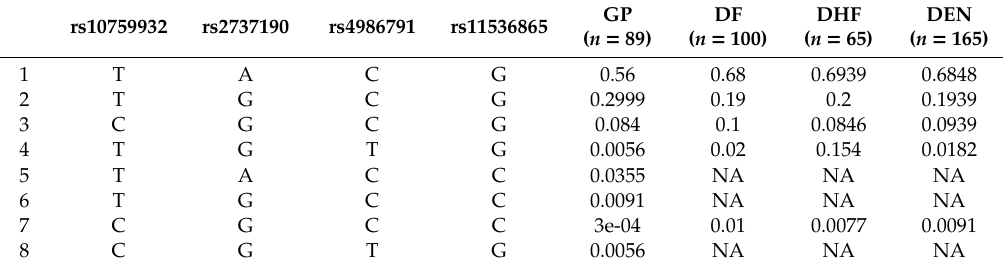
Table 7. Estimation of the haplotype frequencies of the TLR4 gene